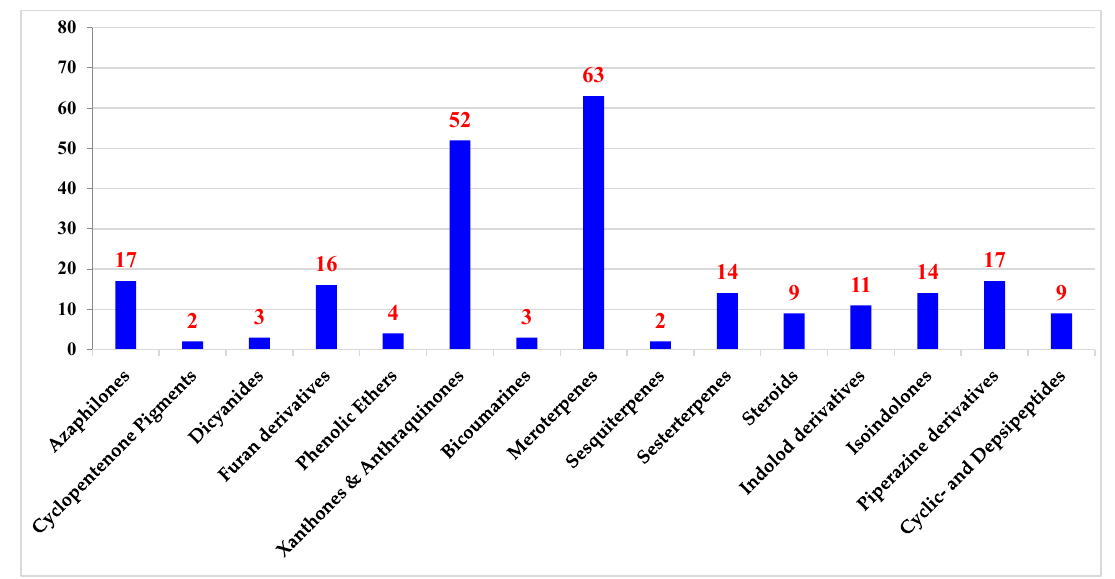
Figure 1. Diversity of chemical classes obtained from the genus Emericella .